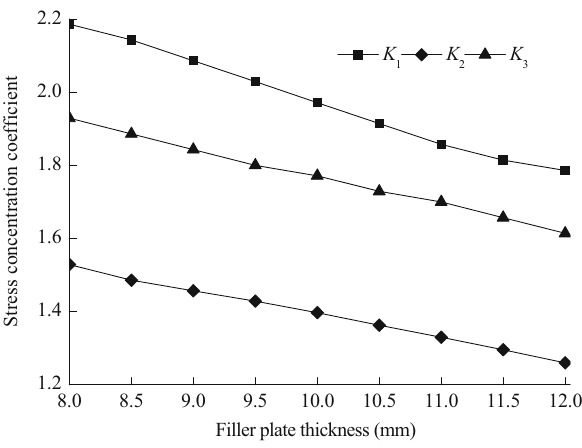
Fig. 7 Relationship between SCC and web thickness